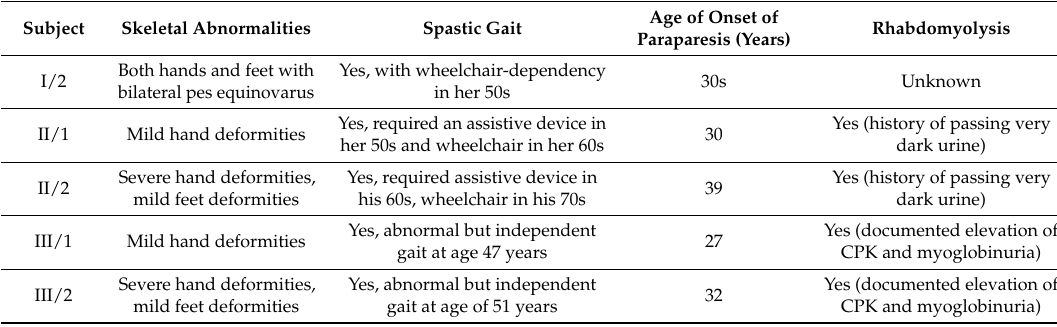
Table 1. Summary of phenotypic features in affected